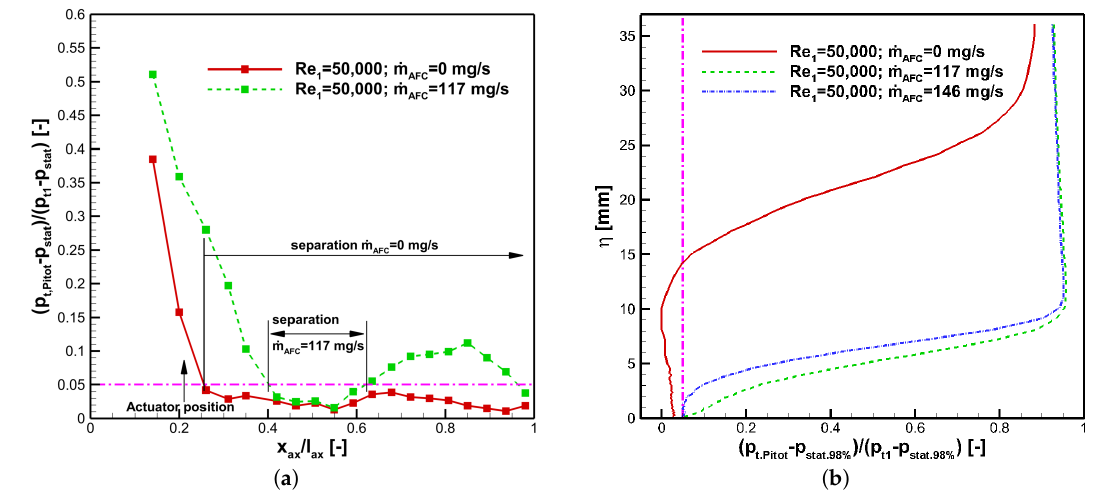
Figure 6. Dynamic pressure ratio ( a ) on the suction side surface and ( b ) as boundary layer profiles at 98% of the axial chord length l ax for different mass flow rates at Re 1 =